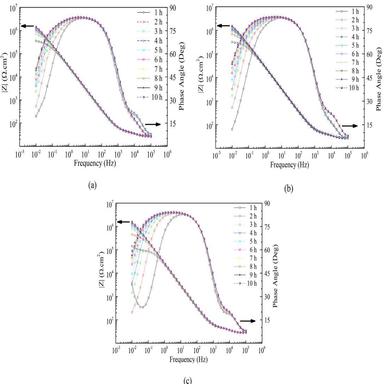
Physical model for simulating an equivalent circuit to fit the EIS data.